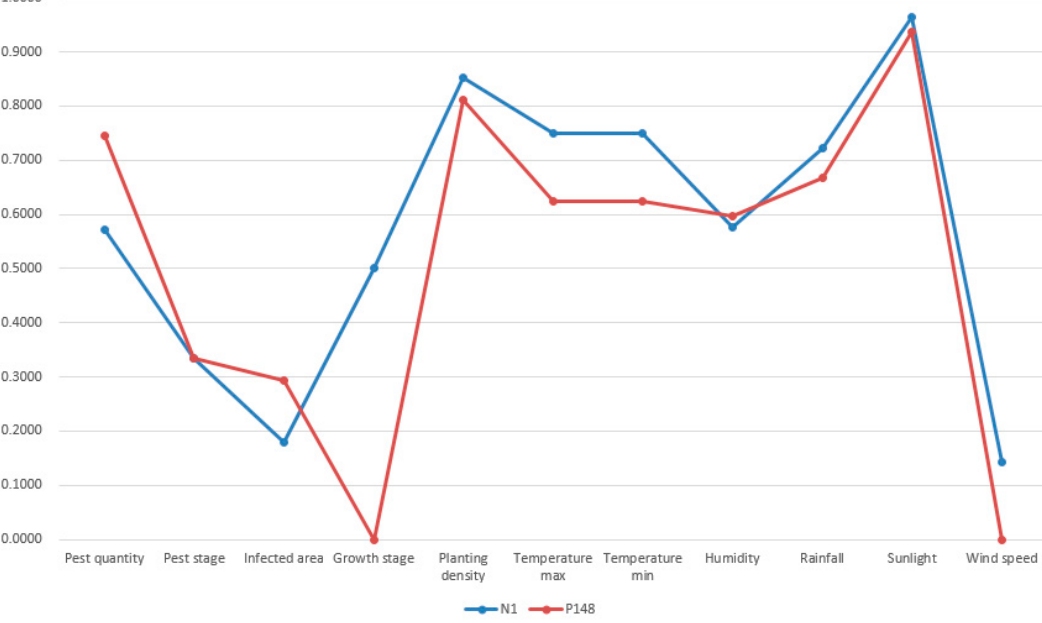
Figure 14. Visualization of the new case 1 and past case 14.